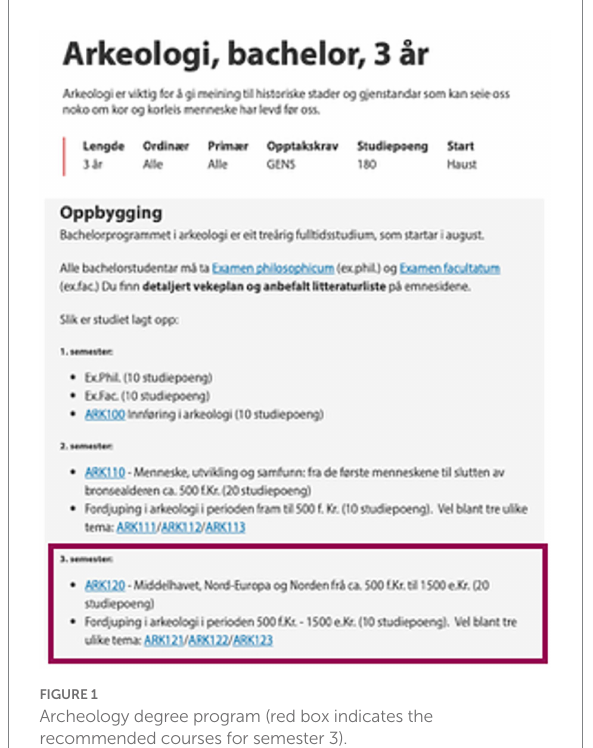
FIGURE 1 Archeology degree program (red box indicates the recommended courses for semester